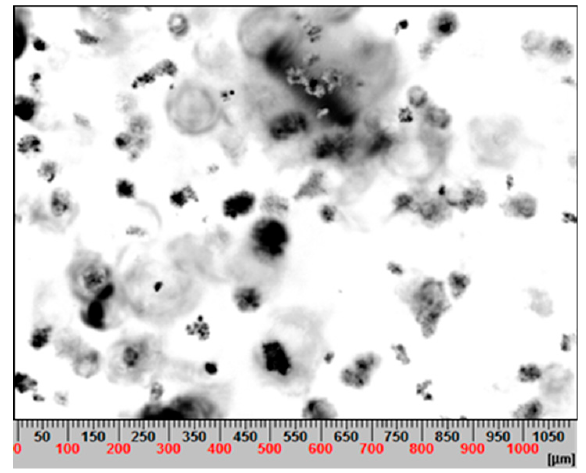
Figure 11. Suspended particles of pyrite in seawater at pH 8 (7 min).